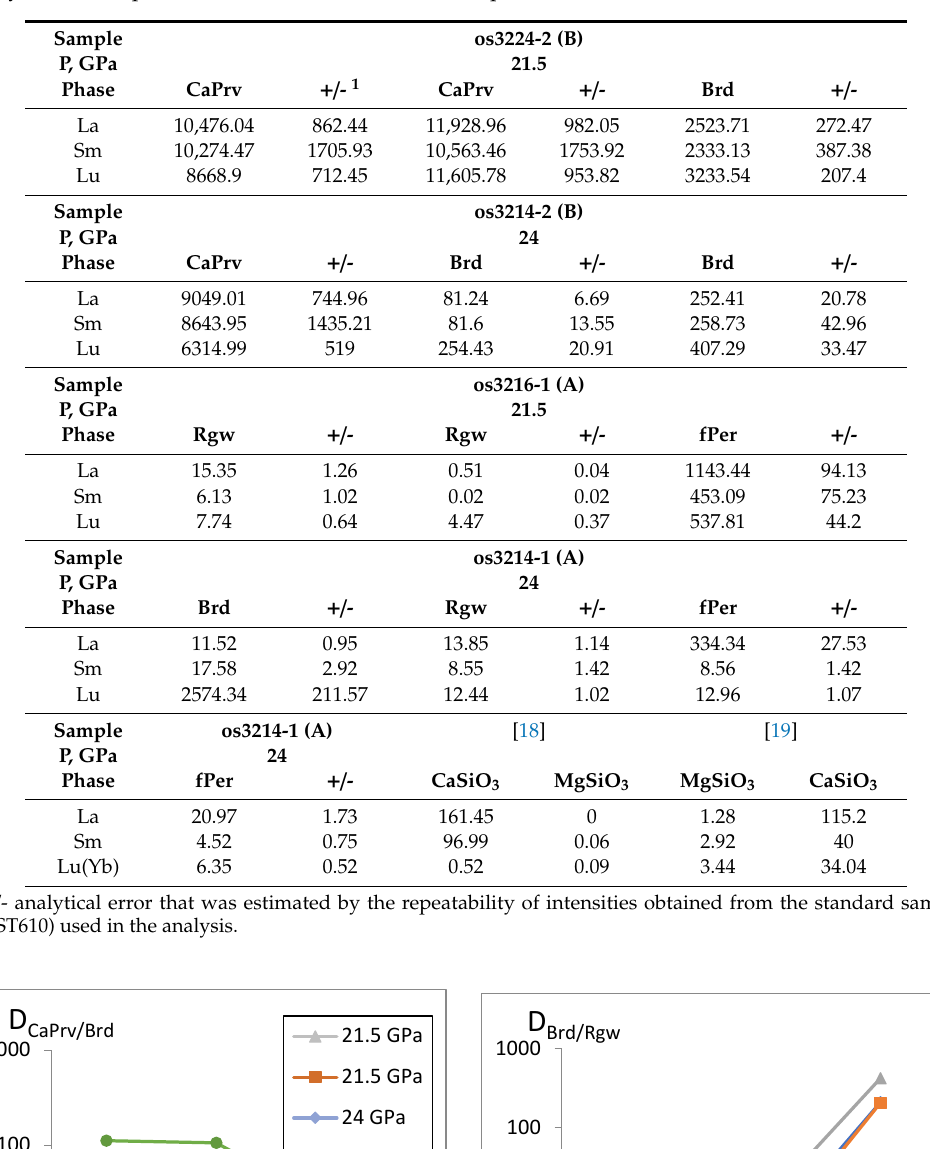
Table 2. Concentrations of trace elements and measurement errors in synthetic phases (ppm, La-ICP-MS analyses) as compared with some natural [18] and experimental [19] data.